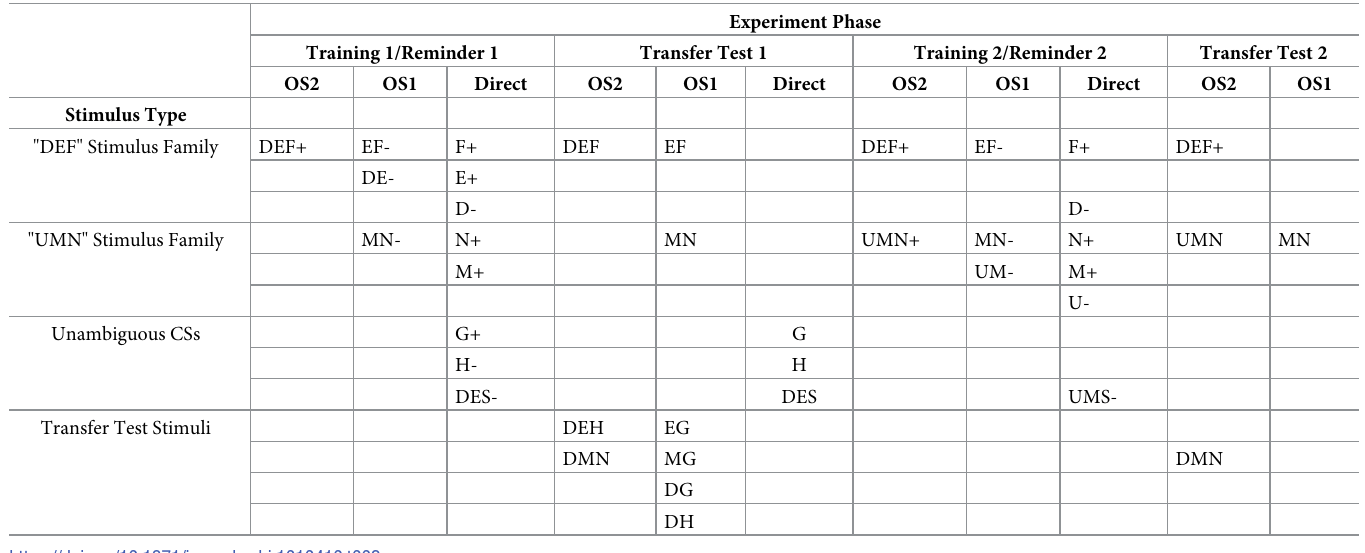
Table 2. Summary of Experiment 2 Design. When three stimuli are listed (e.g., DEF+), 2nd-order occasion setting is hypothesized to be learned (except for DES- and UMS-). When two stimuli are listed (e.g., EF-), 1st-order occasion setting is hypothesized to be learned. When one stimulus is presented (e.g., F+), direct associative learn- ing is hypothesized to be learned. All stimuli within a trial were presented serially. "+" indicates reinforcement; "-" indicates no reinforcement; "OS2" indicates 2nd-order occasion setting; "OS1" indicates 1st-order occasion setting; "Direct" indicates direct associative learning. Notably, the "DEF" family was trained in 2nd-order occasion set- ting before Transfer Test 1 and 2; the "UMN" family was only trained in 1st-order occasion setting before Transfer Test 1 but was trained in 2nd-order occasion setting before Transfer Test 2. This allowed the examination of whether "D" was indeed a 2nd-order occasion setter by testing "D" with "MN" before and after "MN" was trained with 2nd-order occasion setter "U." We predicted "D" would affect "MN" more strongly after "MN" was trained with "U" than before that